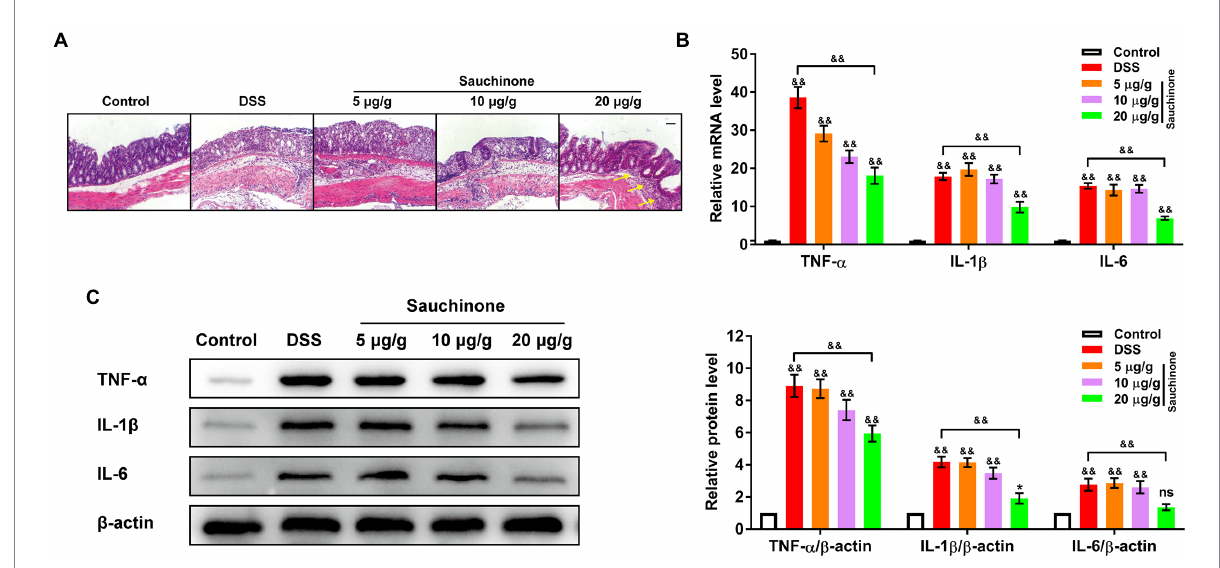
FIGURE 2 Effects of sauchinone on inflammation in DSS-induced UC mice. (A) Representative H&E-stained colon tissue sections (yellow arrow indicates inflammatory cell infiltration; scale bar = 50 μ m). The expression levels of inflammatory cytokines (TNF- а , IL-1 β , and IL-6) in colon tissues were detected by (B) qPCR and (C) western blot. Data are expressed as mean ± standard deviation. * p < 0.05 and && p < 0.01 vs. corresponding control, ns indicates no significant difference; n =